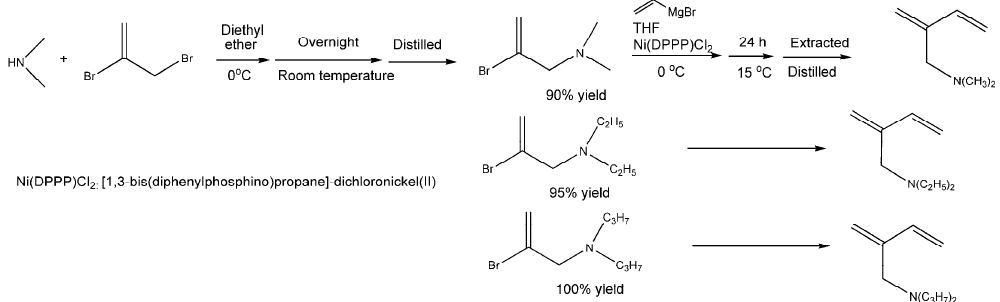
Figure 12. Alternative route for the synthesis of amine groups functionalized 1,3-butadiene [144].